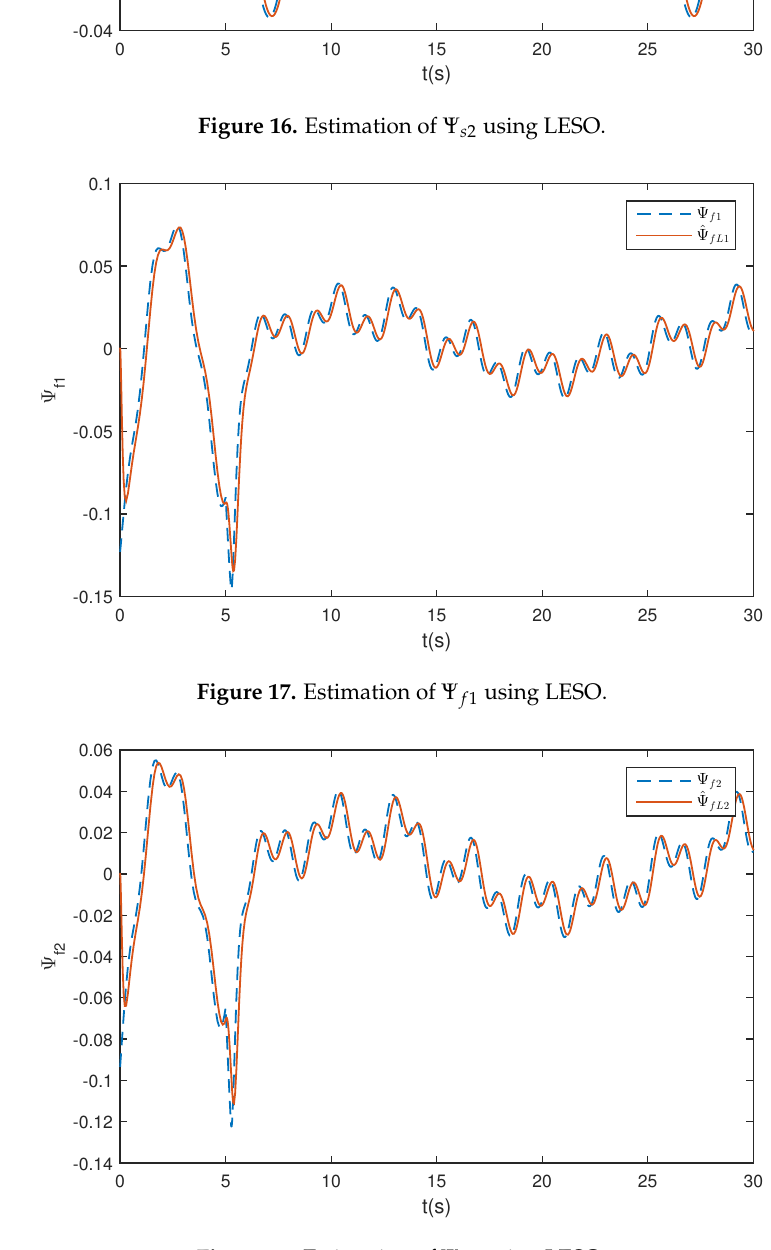
Figure 18. Estimation of Ψ f 2 using